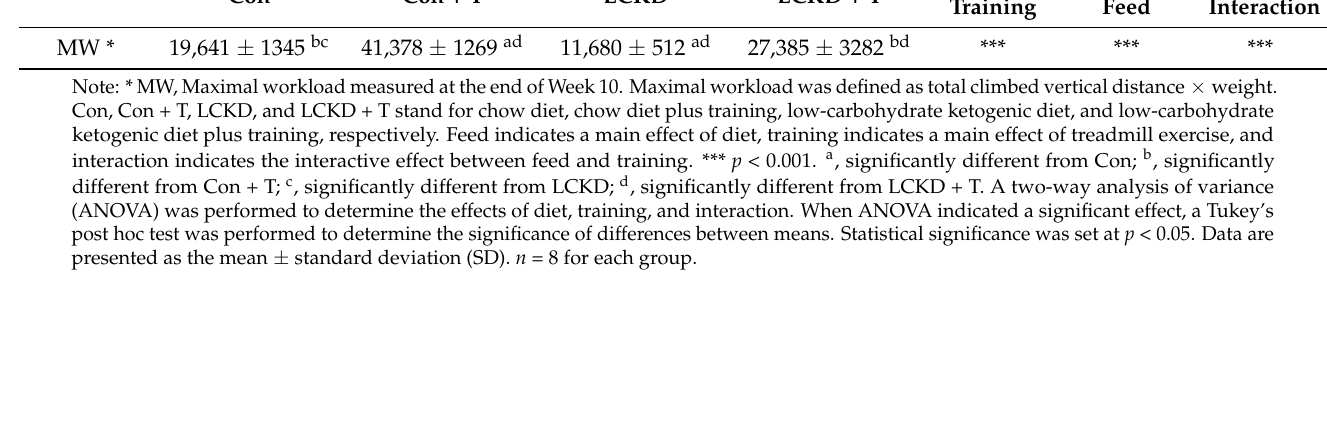
Table 3. Maximal exercise workload after training intervention.